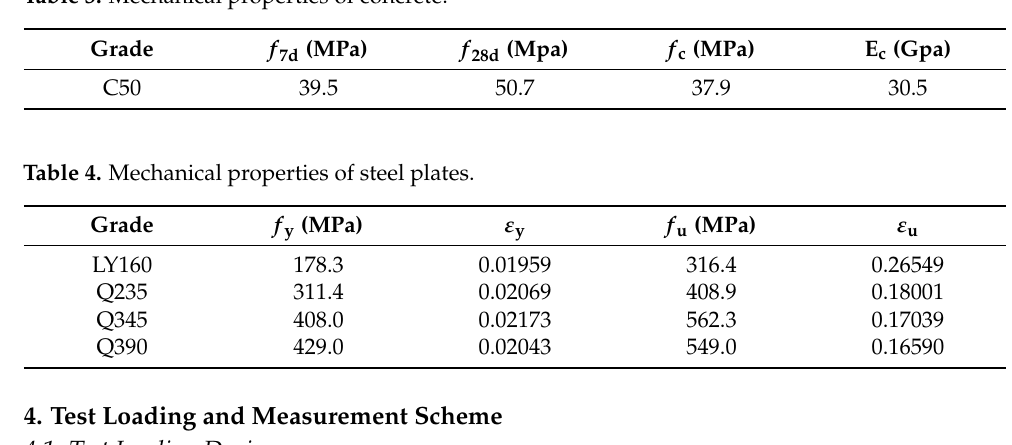
Table 3. Mechanical properties of concrete.